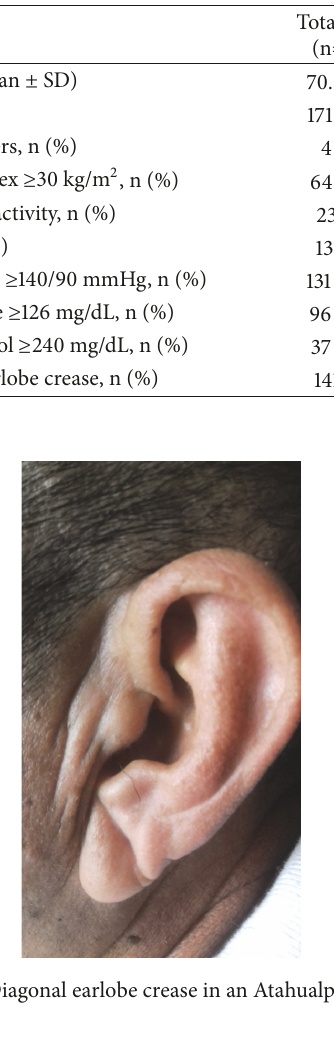
Table 1: Characteristics of Atahualpa residents aged ≥ 60 years across categories of ankle-brachial index determinations (univariate analyses).